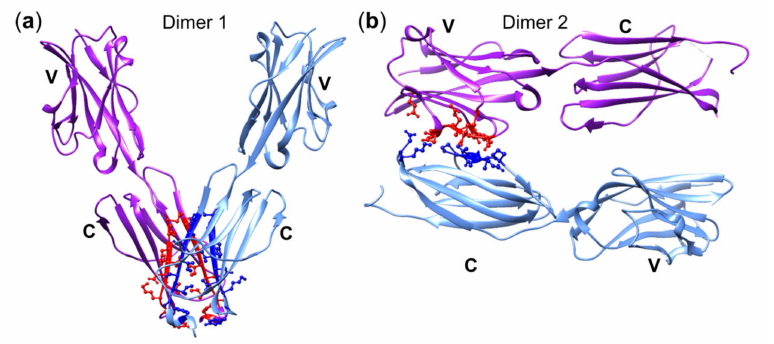
Figure 4. BTN3A ectodomain dimers. ( a ) Dimer 1: The BTN3A–EDs interact at their C domains to form a V-shaped dimer. Interacting residues are highlighted in red and blue. ( b ) Dimer 2: The V domain of a BTN3A–ED interacts with the C domain of another BTN3A–ED, forming a head-to-tail conformation. Interacting residues are highlighted in red (V domain) and blue (C domain). Contact residues of either domain [57] are according to the PDB protein structures 4F9L and 4F80 and were modified with USCF